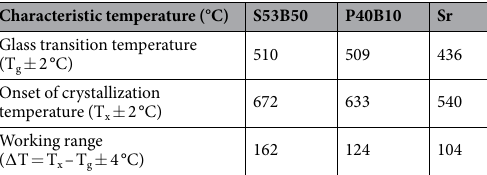
Table 2. Glass transition temperature (T g ), onset of crystallization temperature (T x ), and working range ( ∆ T) of S53B50, P40B10 and Sr bioactive glasses, as determined by differential thermal analysis (DTA).